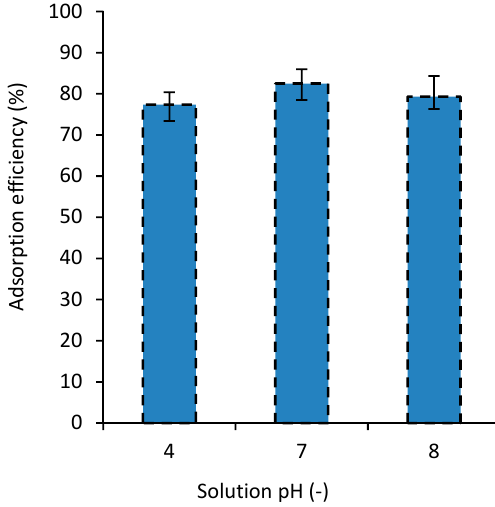
Figure 6. The e ff ect of solution pH on MB adsorption e ffi ciency ( T = 27 ◦ C and C 0 = 50 mg / Figure 6. The effect of solution pH on MB adsorption efficiency (T = 27 °C and C 0 = 50 mg/L).